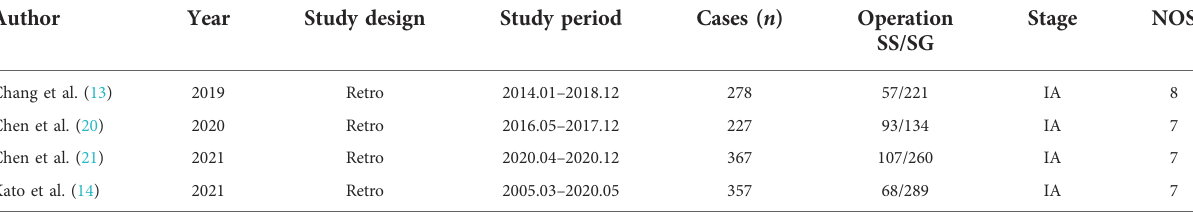
TABLE 1 Characteristics of identi fi ed studies.